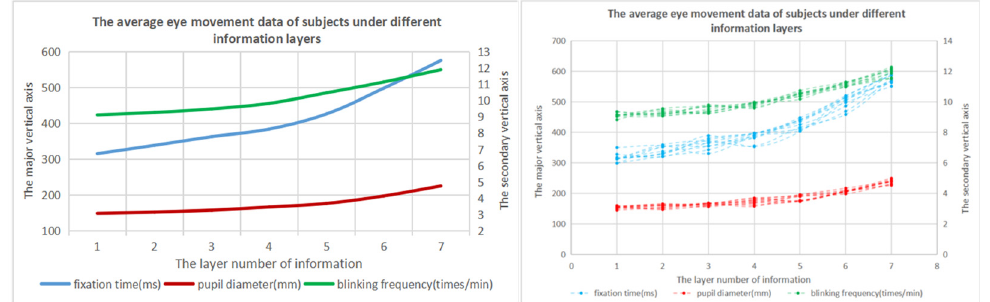
Figure 16. Change trend graph of subjects’ eye movement data under different numbers of informa- tion layers.